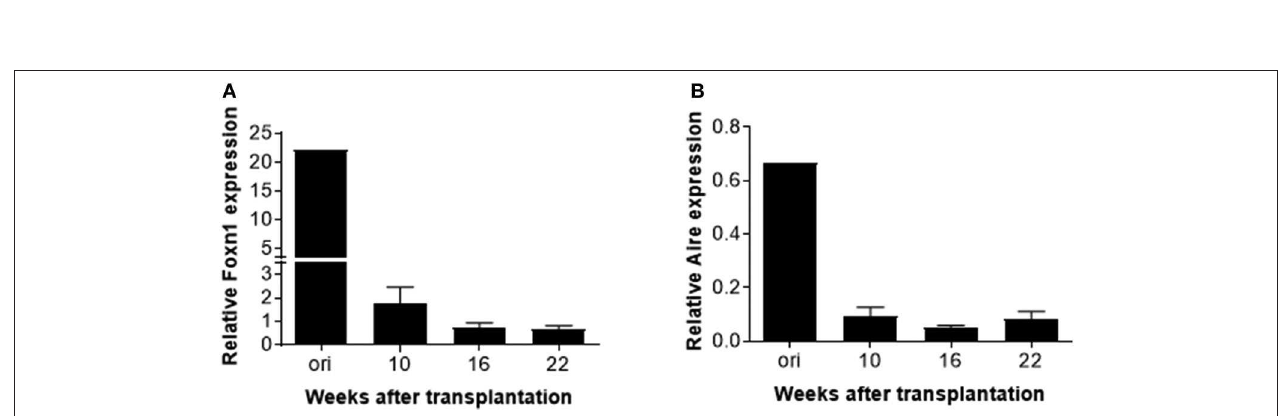
FIGURE 5 | AIRE and FOXN1 expression in TECs in human thymic grafts. Human thymic grafts prepared from hu-mice at weeks 10, 16 and 22 were analyzed for FOXN1 , AIRE, and EpCAM gene expression by real-time RT-PCR analysis. Relative expression levels (normalized to EpCAM) of FOXN1 (A) and AIRE (B) genes shown as the mean ± SEM ( n = 3–4 animals were analyzed at each time point).